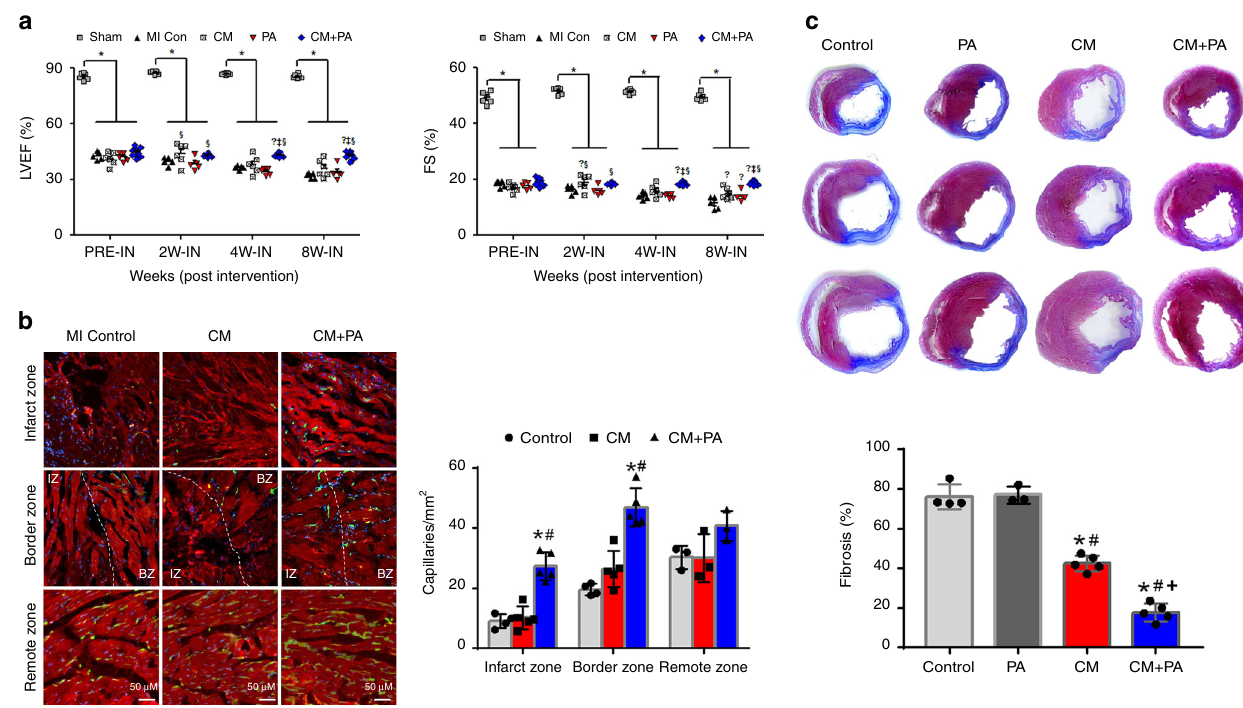
Fig. 3 Dual approach improved cardiac function, capillary density, and reduced scar formation following MI. a Improvement of cardiac function in rats receiving hiPSC-CMs with hMSC-PA. Fractional shortening (FS) and ejection fraction (EF) were signi fi cantly higher in the hiPSC-CM with hMSC-PA group compared with other groups measured by echocardiography. The data are represented as mean ± SEM. * p < 0.05 compared with Sham group, † p < 0.05 compared with MI CON group, ‡ p < 0.05 compared with CM group, § p < 0.05 compared with PA group; n = 5 animals per group. One-way ANOVA was used for statistical analyses. b Representative images of capillaries stained with FITC-IsB4 (green) on the infarct zone, border zone, and the remote zone at 8 weeks after MI and their quanti fi cation summary. For quanti fi cation, the number of capillaries on fi ve randomly selected fi elds in each heart was counted. Scale bars: 100 µ m. The data are represented as mean ± SEM. * p < 0.05 compared with control, # p < 0.05 compared with the CM group; n = 5 independent samples per group. One-way ANOVA was used for statistical analyses. c Representative images from the four experimental groups showing cardiac fi brosis after staining with Masson ’ s trichrome in the hearts harvested 8 weeks after MI and their quanti fi cation results. The data are represented as mean ± SEM. * p < 0.05 compared with control, # p < 0.05 compared with the PA group, and + p < 0.05 compared with the CM group; n = 5 biologically independent samples per group. One-way ANOVA was used for statistical analyses. Sham Sham operation, MI CON MI control, CM hiPSC-CMs, PA hMSC-loaded patch, CM + PA hiPSC-CMs + hMSC-loaded